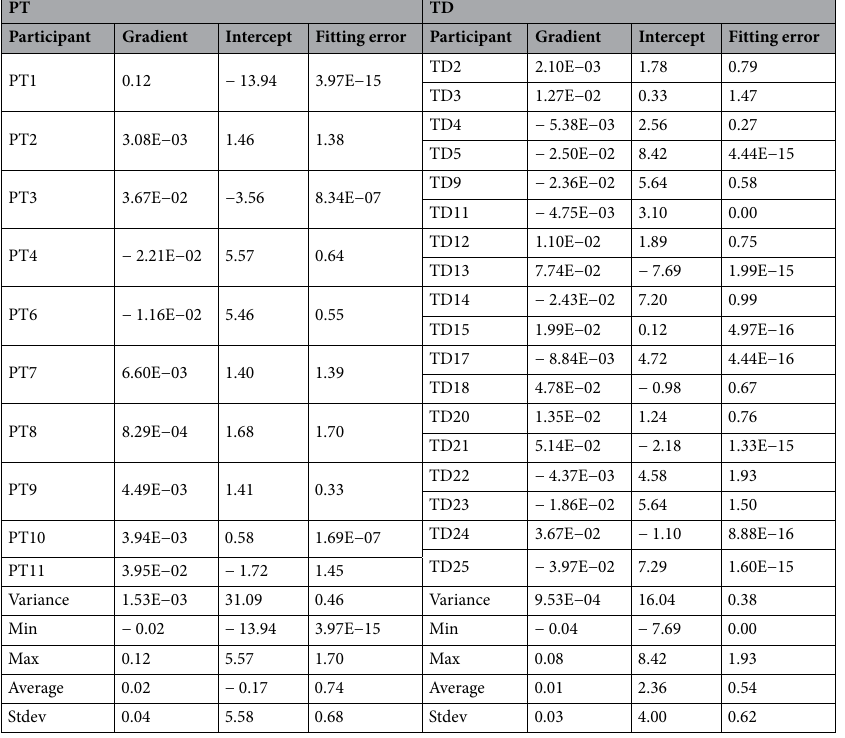
Table 2. Gradience, intercept, and fitting error values from best-fitted line between alpha-motor relative powers and age at respective visits. Variance, minimum, maximum, average, and standard deviation were calculated within the subset of infants who had two or more visits shown